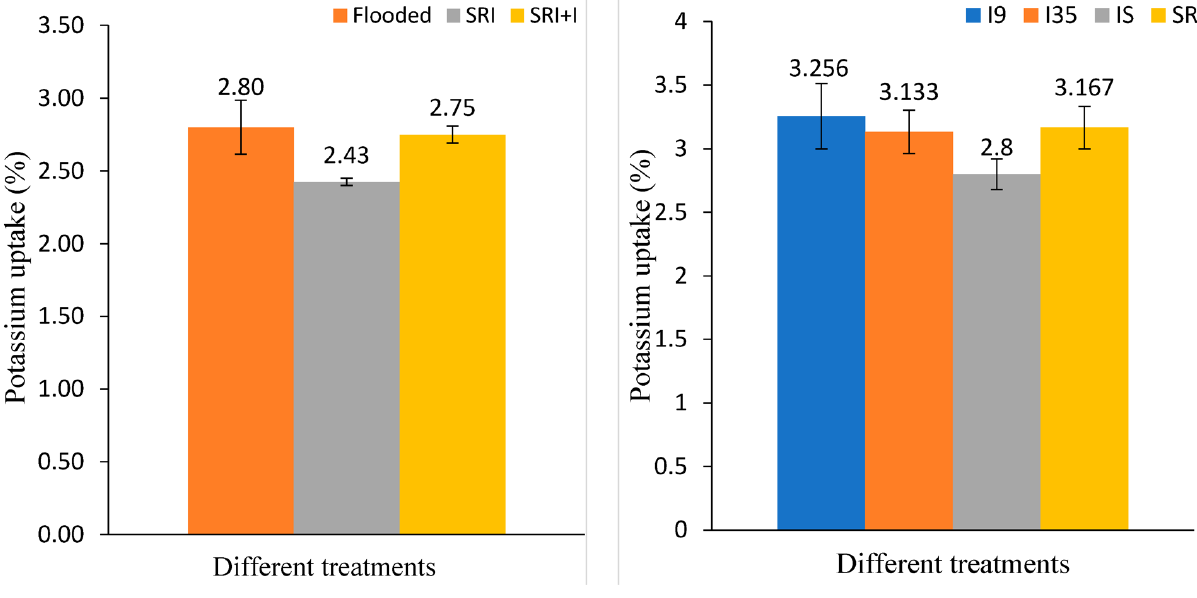
Figure 11. Phosphorous uptake as measured in the different treatments. Conventional flooded rice (CFR), SRI, and SRI with intercropping (SRI+I or SRIBI) in 2017 ( Left ). SRI and three different intercropping configurations in 2018 ( Right ). As a general trend, the uptake of essential nutrients, nitrogen, phosphorous, and po- tassium, was found to be higher with intercropping as compared to the control SRI treat- ment. 3.2.2. Chlorophyll Content A significant difference was observed in the Chlorophyll-a and Chlorophyll-b con- tent of the rice plants grown under SRI and SRIBI ( p ≤ 0.05). A higher chlorophyll content in SRI as compared to the conventional flooded rice (CFR) has also been reported in pre- vious studies [63]. While the mean value of Chlorophyll-a was 9.3 for CFR and SRI, it was 13.2 for SRIBI (SRI+I), which was significantly higher ( p = 0.05) than that of SRI (9.2) (Fig- ure 12). On the other hand, the mean value of Chlorophyll-b was 3.0 for CFR, while it was